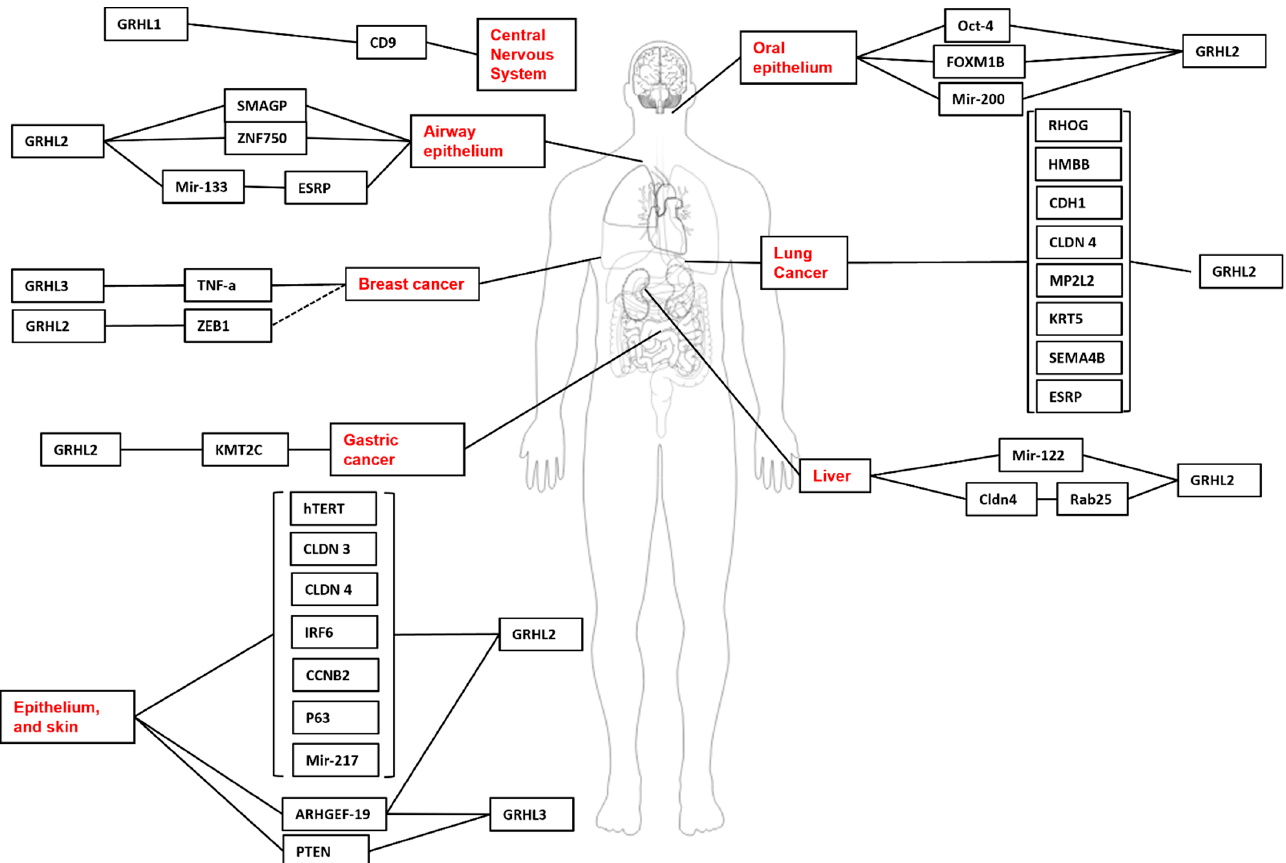
Figure 1. Grainyhead-like target genes in human development and disease. GRHL1 upregulates CD9 in the development of neuroblastomas. In Airway epithelium, GRHL2 regulates the expression of SMAGP and ZNF750 in airway cell polarity, barrier maintenance and cell differentiation. Similarly, mir-133 is regulated by GRHL2 and controls EMT in the airway epithelium through its own regulation of ESRP. A host of genes are regulated by GRHL2 in lung tumourigenesis, including HMBB, CLDN4, CDH1, MP2L2, KRT5, SEMA4B, ESRP and RHOG. GRHL3 regulates TNF- in endothelial cell migration in breast cancer cell lines and PTEN in squamous cell carcinoma. GRHL2 is also involved in cancer progression, regulating KMT2C in gastric cancer lines. Further, GRHL2 also regulates Oct-4, Mir-200 and Foxm1b in oral epithelium, as well as mir-122 in the differentiation of hepatocytes and RAB25 in liver cancer. GRHL2 regulates various genes with processes in the epithelium, including hTERT, Claudin 3 and 4, IRF6, CCNB2, p63, Mir-218. Both GRHL2 and GRHL3 co-operate in the regulation of ARHGEF19 in epidermal wound repair.